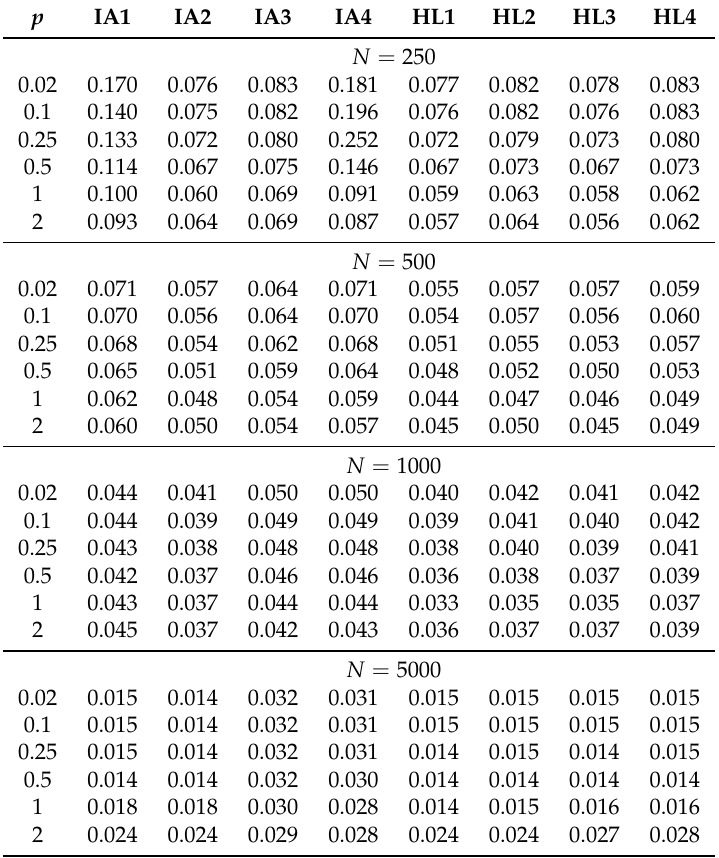
Table A4. Simulation Study 2: Average Root Mean Square Error (ARMSE) of Group Standard Deviations as a Function of Sample Size in the Condition of Differential Item Functioning (DIF) and G = 6